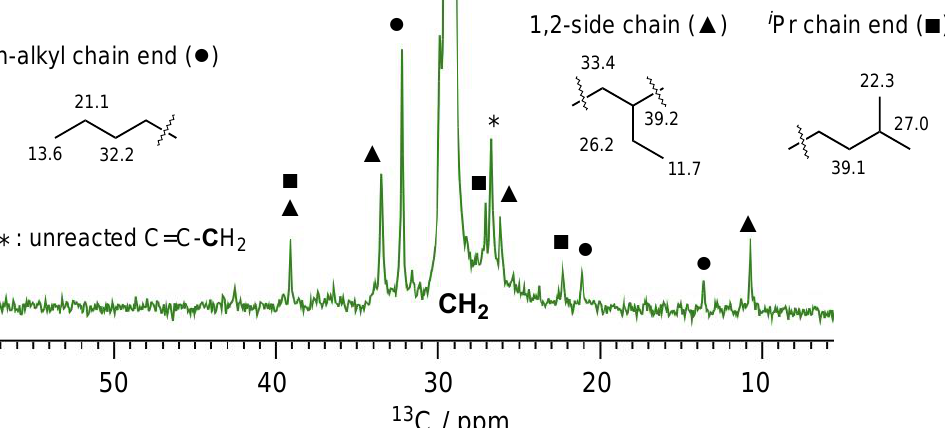
Figure 3. The 13 C NMR spectrum of hydrogenated polybutadiene obtained in Scheme 4 (125 MHz, in C 2 D 2 Cl 4 ).